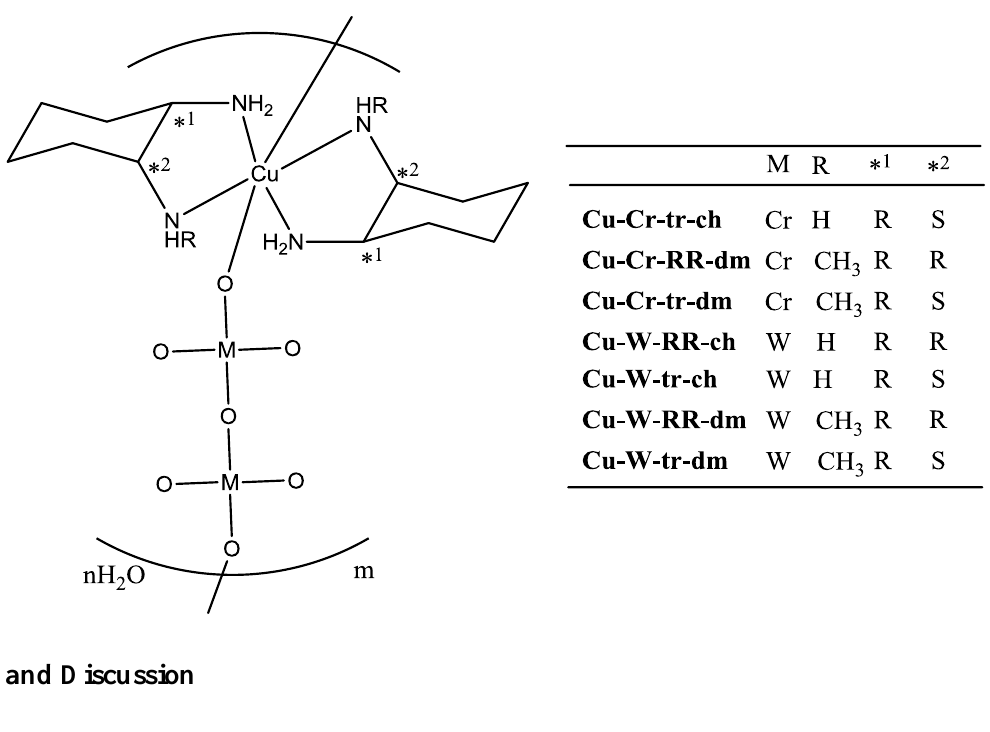
Figure 1. Molecular structures of the coordination polymers with